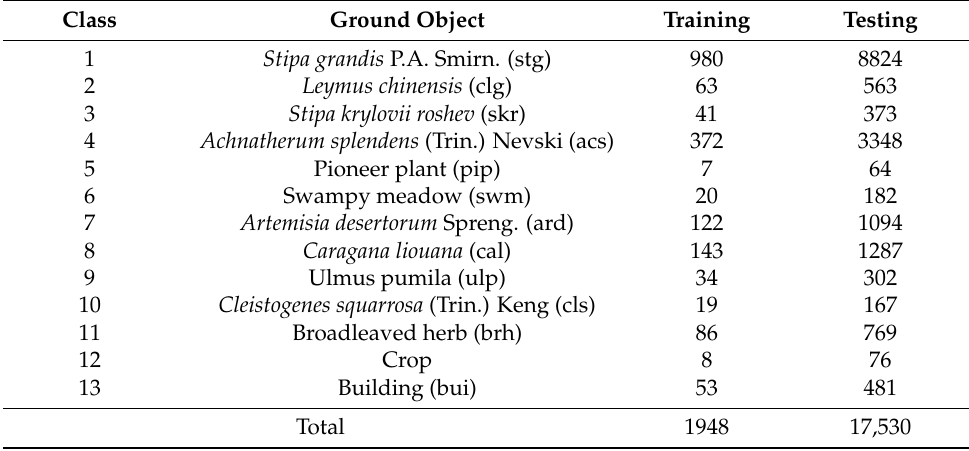
Table 2. The sample information of the Xilinhot